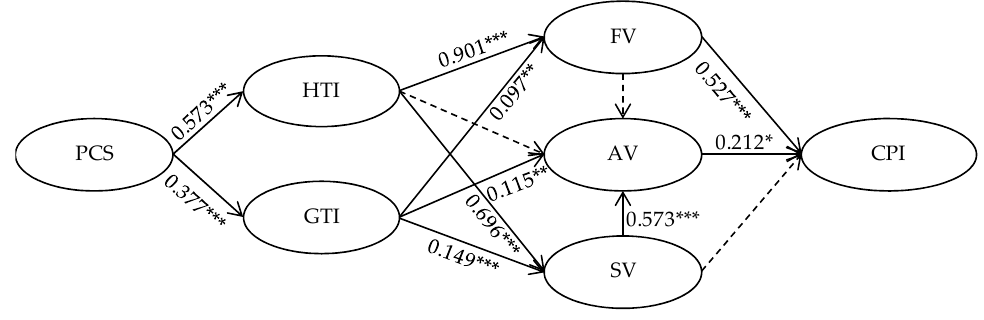
Figure 2. Path coefficient of the hypothesis model. * p < 0.05; ** p < 0.01; *** p < 0.001. Figure 2. Path coe ffi cient of the hypothesis model. * p < 0.05; ** p < 0.01; *** p <